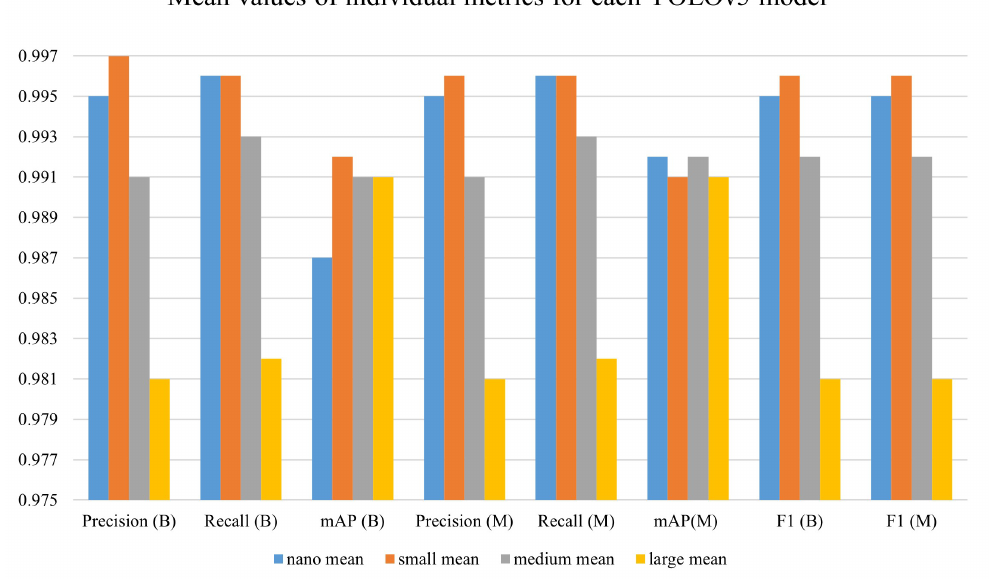
Figure 5. Mean values of individual metrics for each YOLOv5 model.